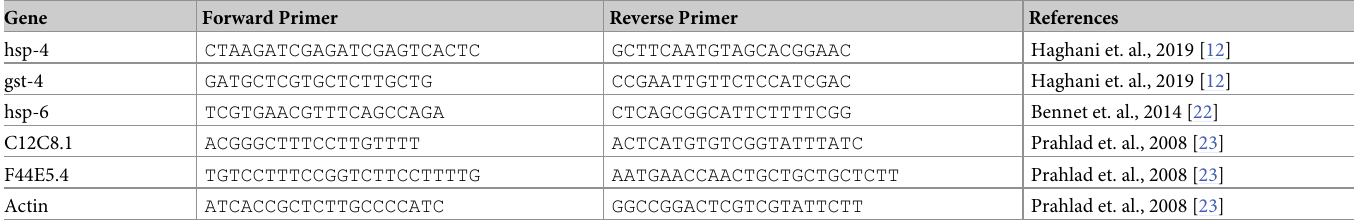
Table 2. Primers used to investigate changes in gene